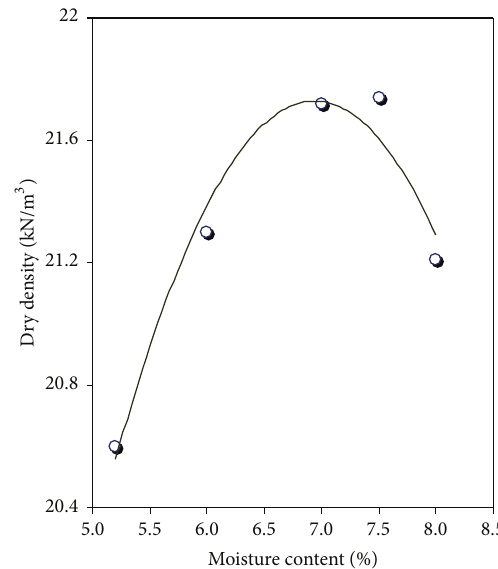
Figure 2: Specific gravity distribution of subsoil.